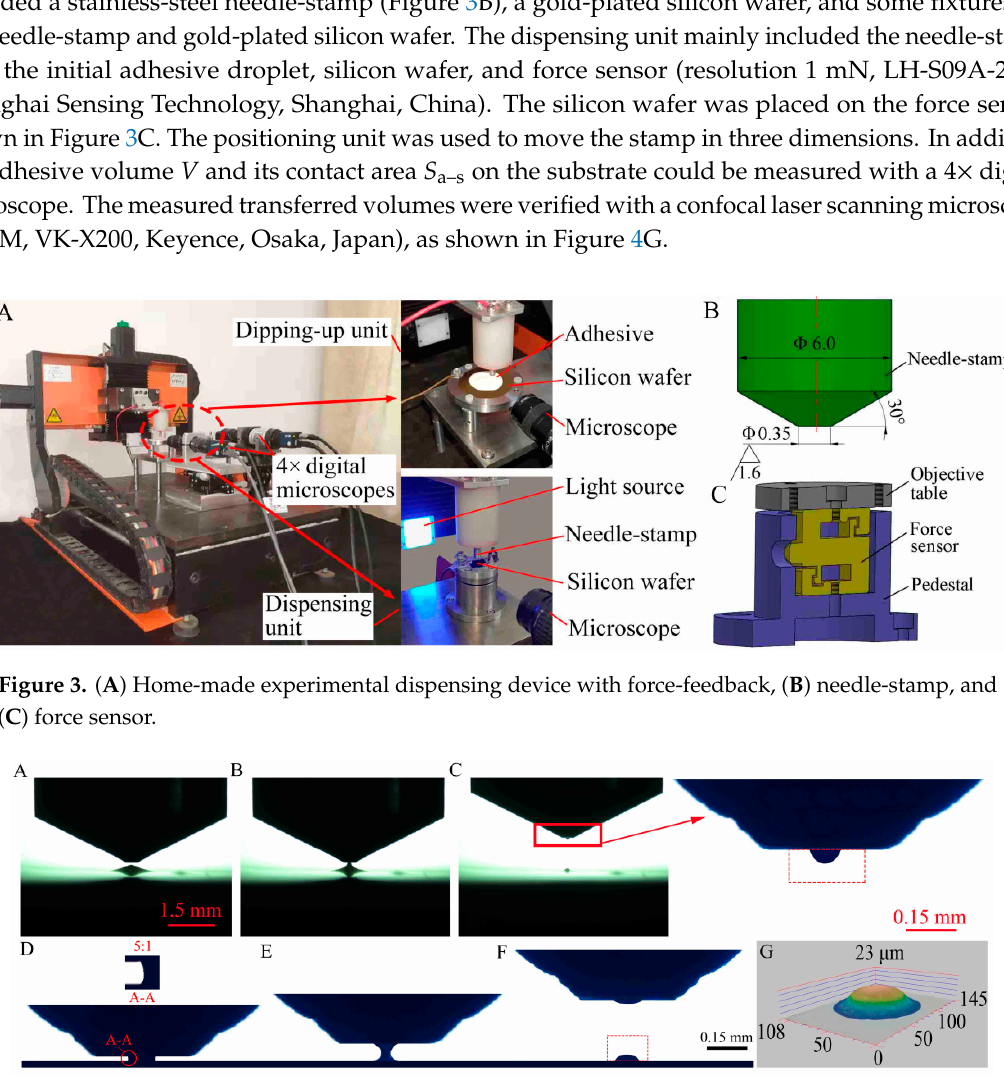
Figure 4. Adhesive dispensing with the needle-stamp in experiment under 1 mN: ( A – C ) dipping-up, ( D ) squeezing, ( E , F ) stretching, and ( G ) micrograph of transferred adhesive with a confocal laser scanning microscope (CLSM).